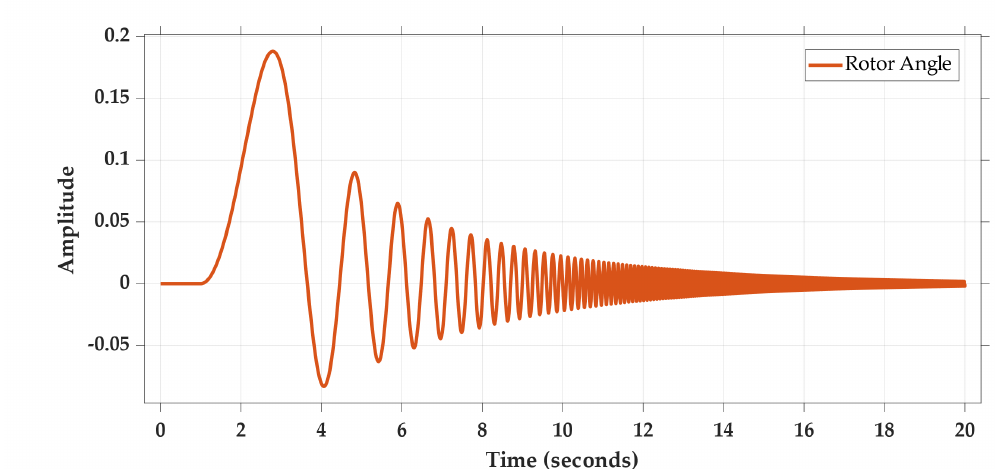
Figure 1. Synchronous generator rotor angle when E FD = 1, P m = 1, and no initial conditions.